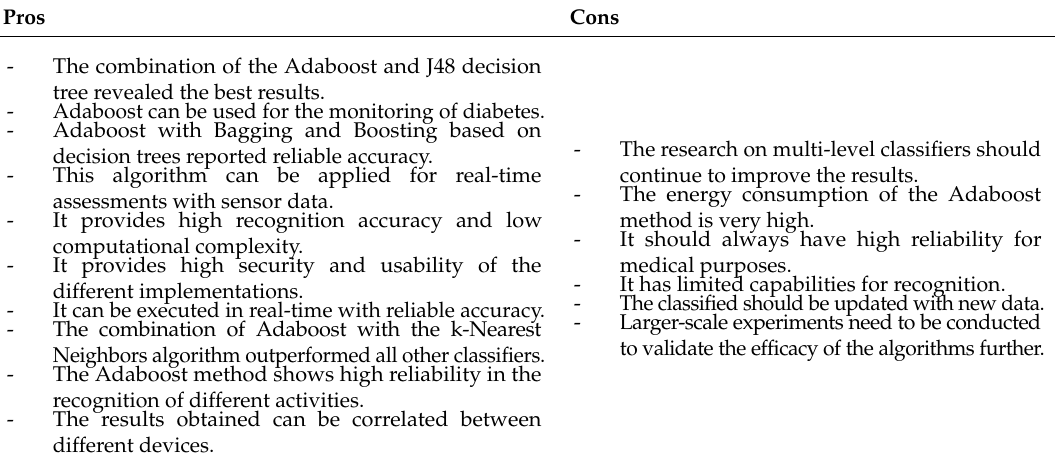
Table 4. Advantages and disadvantages of the use of Adaboost method in the different studies